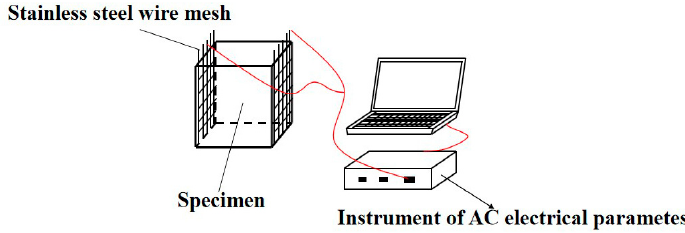
Figure 1. The schematic diagram of AC electrical resistance measurement.